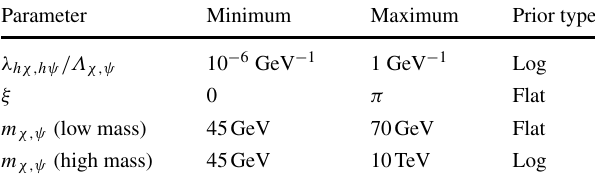
Table 4 Parameter ranges and priors for the fermion DM models. Our choice for the range of ξ between 0 and π reflects the fact that only odd powers of cos ξ appear in the observables that we consider, but never odd powers of sin ξ , which cancel exactly due to the complex conjugation. Thus, the underlying physics is symmetric under ξ → − ξ Parameter Minimum